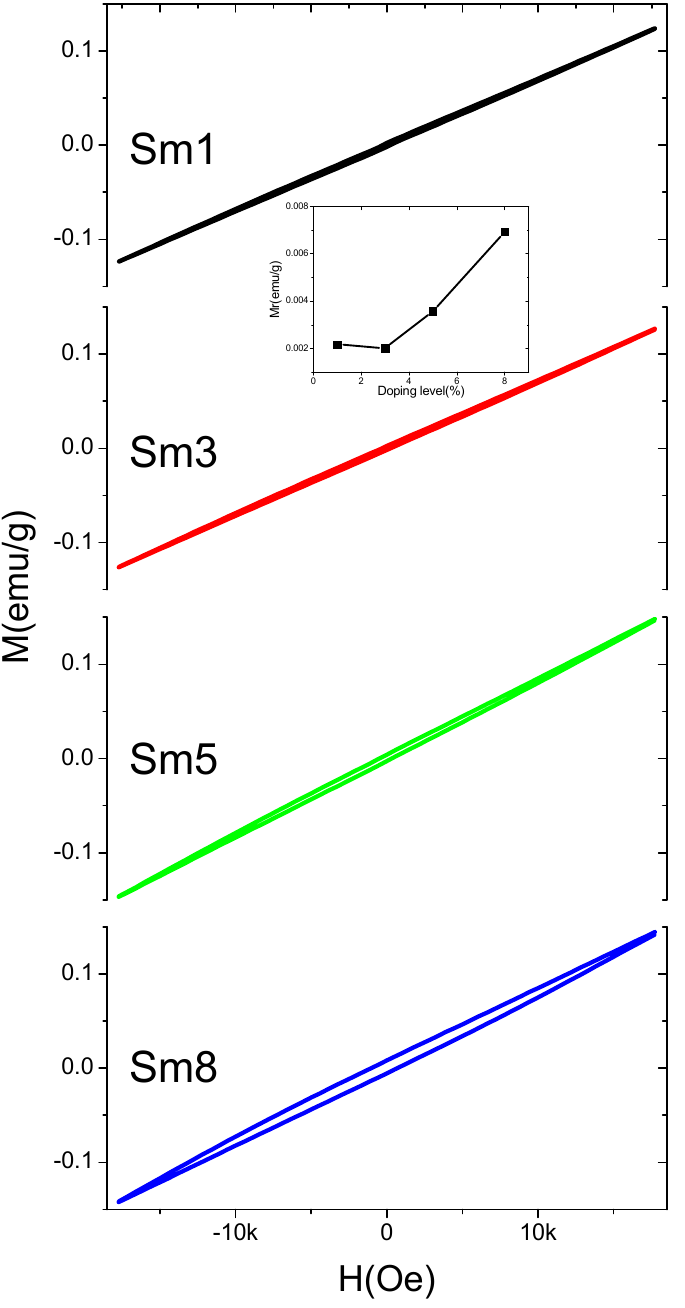
Figure 9. The magnetic M–H loops of the 825 °C-sintered samples. The insets in the figure show the composition dependency of remnant magnetization (M r ).